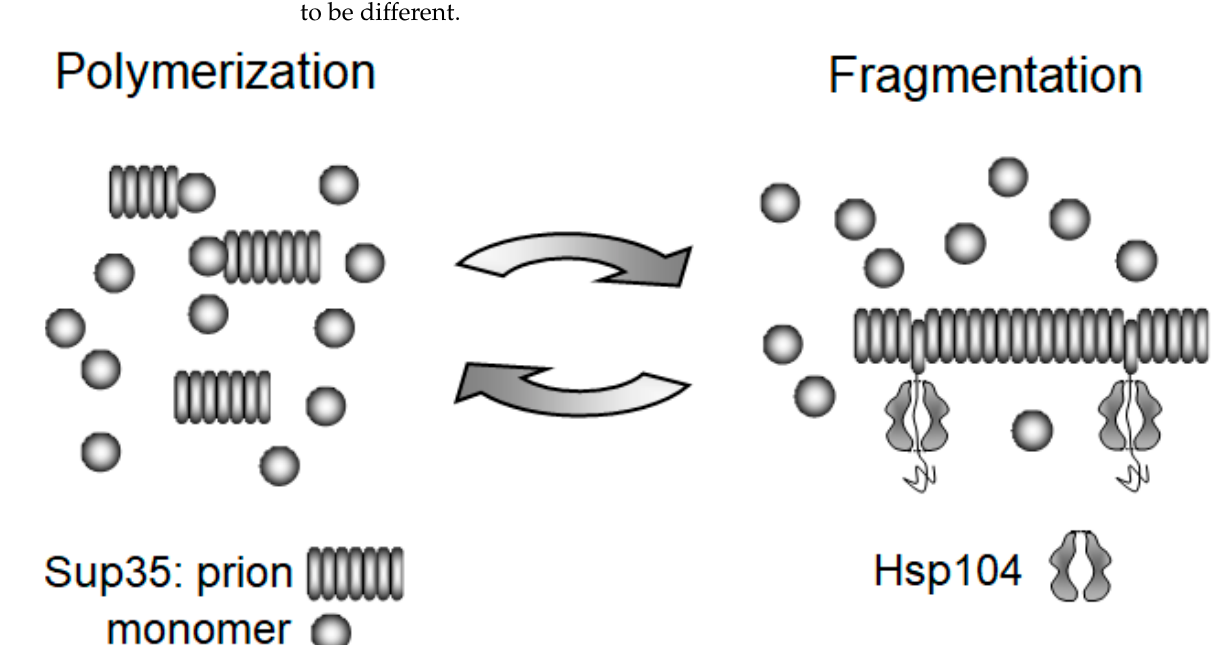
Figure 2. Yeast prion replication cycle [29]. Prion fibrils are multiplied through the action of Hsp104, which randomly extracts protomers from amyloid, thus fragmenting it into smaller pieces. The size of amyloid fragments is restored through growth by accretion of soluble Sup35 molecules. The action of Hsp104 is preceded by, and depends on, binding of the Sis1 and Ssa chaperones [66], which are not shown here.